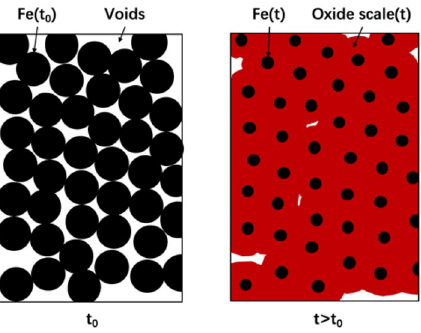
Figure 2. Illustration of the reactive zone before (left) and after corrosion of a layer of metallic iron